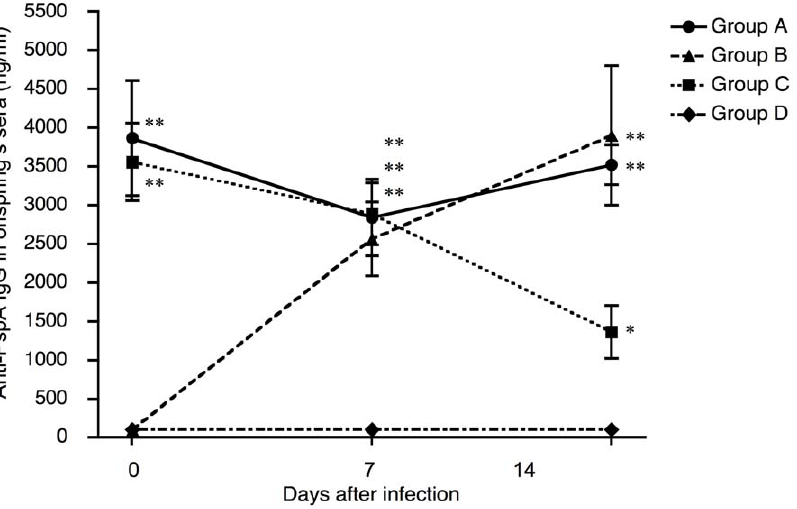
Figure 3. Anti-PspA specific antibodies in sera of offspring. The levels of anti-PspA specific IgG in sera of offspring were determined by PspA- specific ELISA at days 0, 7, and 14 after the birth. Group A mice were the offspring delivered from PspA-immunized mothers and breast-fed by the same mothers (n=26). Group B mice were offspring from sham-immunized mothers and breast-fed by PspA-immunized mothers (n=22). Group C mice were offspring from PspA-immunized mothers and breast-fed by sham-immunized mothers (n=27). Group D mice were offspring from sham- immunized mother and breast-fed by the same mother (n=18). The values shown are the mean 6 S.E. concentrations (ng/ml). * p , 0.05 and ** p , 0.01 when compared with offspring in Group D by ANOVA test with Dunn’s multiple comparison test.